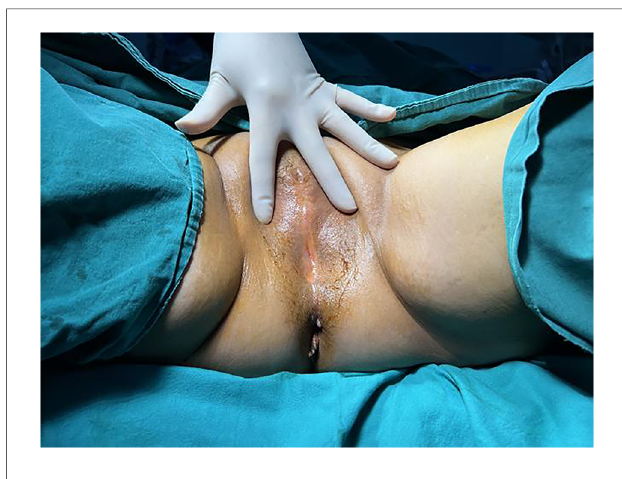
FIGURE 1 Dense adhesion of the labia from the clitoris and to the perineum.